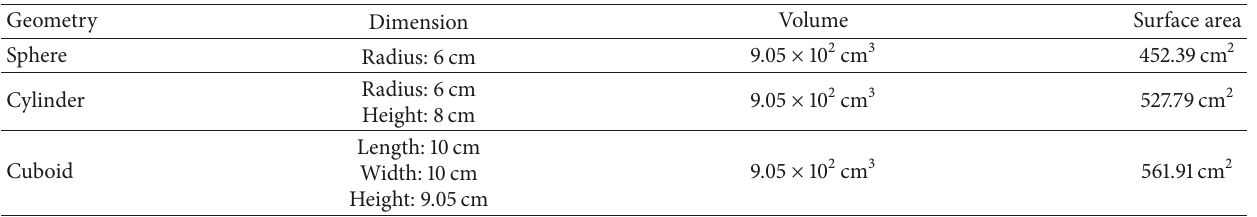
Table 1: Parameters of the 3 uranium components.